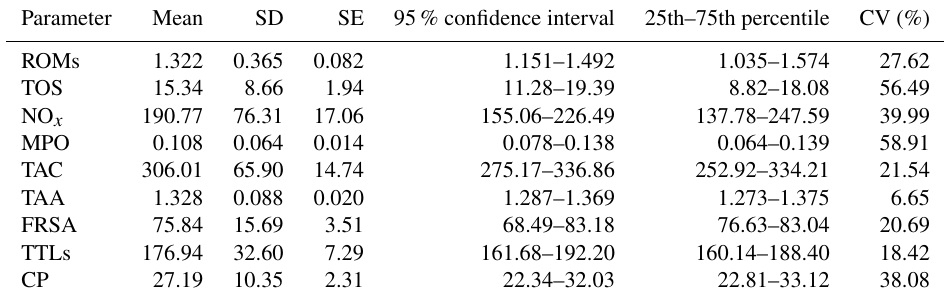
ROMs: reactive oxygen metabolites ( t -BHP equivalents, mM); TOS: total oxidant status ( t -BHP equivalents, µ M ); NO x : nitric oxide metabolites (NaNO 3 equivalents, µ M ); MPO: myeloperoxidase (optical densities, 450nm); TAC: total antioxidant capacity